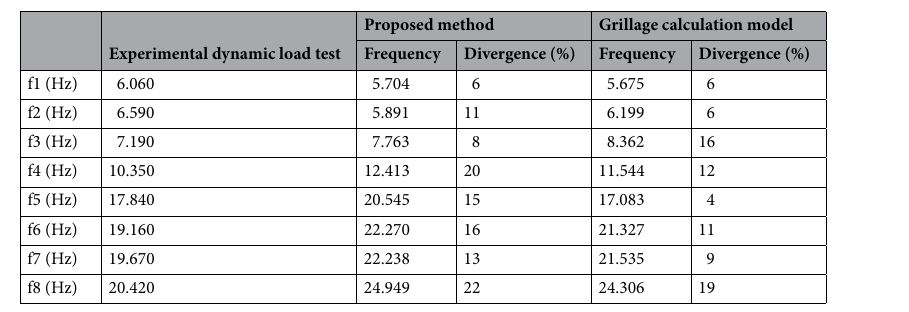
Table 3. Theoretical-empirical comparative